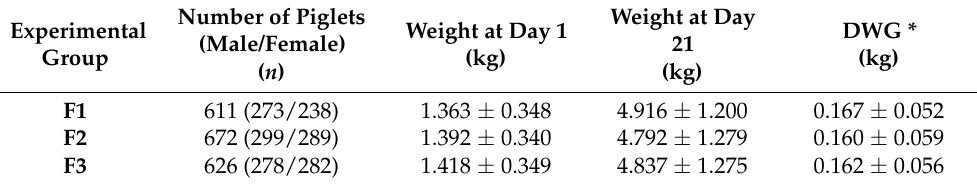
Table 5. Weight at day 1 (kg), weight at day 21 (kg), and daily weight gain (DWG, kg) of piglets derived from inseminated sows from three experimental groups (F1, F2, F3). Data are represented as the mean ± SD (standard deviation).